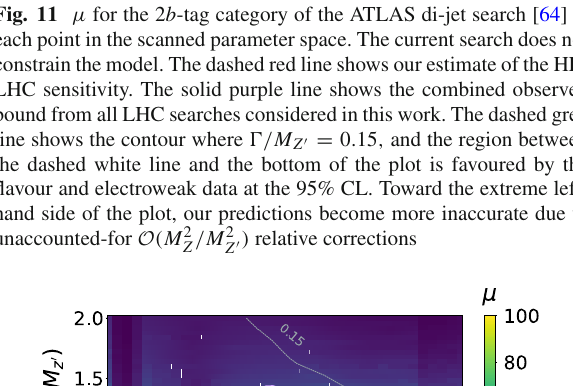
The t ¯ t search results are presented for 1 . 9 TeV < M Z (cid:2)